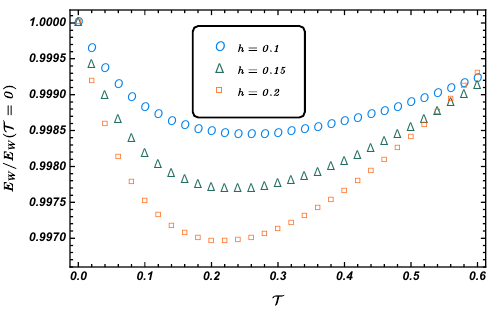
Figure 5 . EoP as a function of the energy flux for different values of h in d = 3 with ‘ = 1